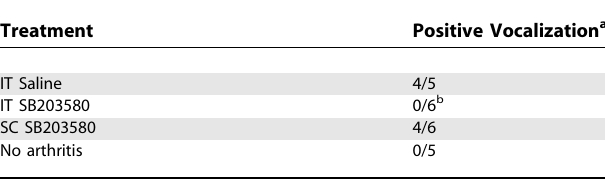
Table 1. Behavioral Pain Effect of IT p38 Inhibitor in Adjuvant